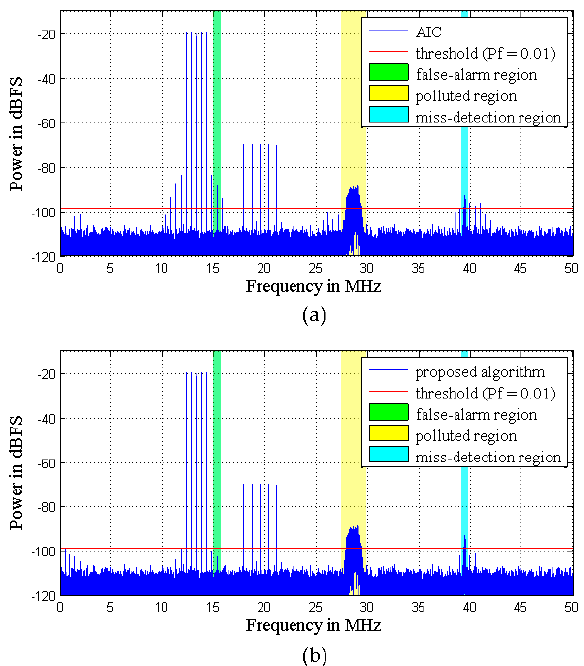
Figure 7. Simulation results with the signal used in Figure 4 and mitigation with ( a ) adaptive interference cancellation (AIC); ( b ) the proposed algorithm.